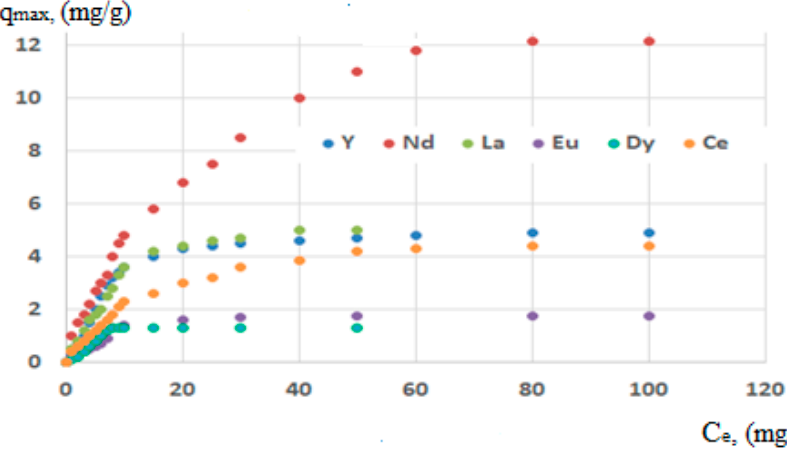
Figure 9. Isotherm of rare-earth metals (REM) adsorption from model solutions at pH = 4, sorbent No. 3. Table 4. Maximum sorption capacity, coefficients of Langmuir and Freundlich adsorption isotherms for rare-earth metals by sorbent No. 3, at pH = 4.